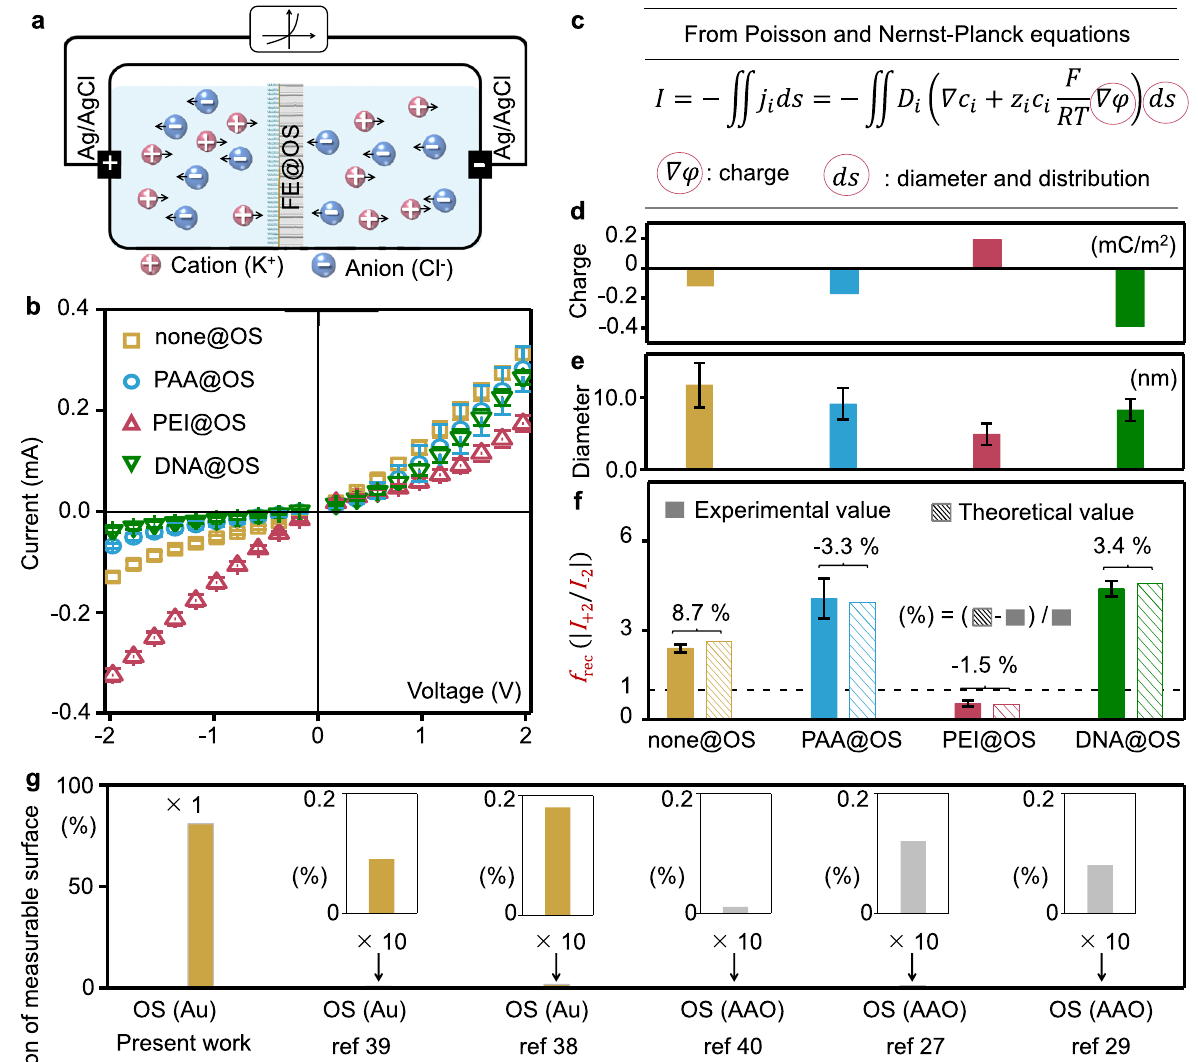
Fig. 3 Explicit role of FE OS in regulating-ion-transport. a Scheme of a two-electrode cell. b I – V curves characterizing the ion transport through nanochannel-system. c The PNP equation was used for numerical simulations of the effect from FE OS on the ion transport through nanochannel, where two variables remain: ∇ c i and ∇ φ valued by the surface charge density ( σ ) (measured by SSZPA, Fig. 3d) (1), the diameter of nanochannels (measured by AFM, Fig. 3e) (2) and the depth of FE at IW (measured by ToF-SIMS, Fig. 2g) (3) (More details in the section “ Numerical simulation ” in “ Method ” section). Thus, unless otherwise stated, the I is available from numerical simulations using the three parameters (1), (2) and (3) measurable in the nanochannel-system with FE OS only but without FE IW . f Comparison of the recti fi cation ratio ( f rec ) measured from I – V tests (experimental value) with the f rec from numerical simulations based on classical equations using measured parameters (theoretical value), but not estimated values like the previous works in 1st and 2nd stage. g Fraction of the measurable surface, which is the area proportion of the OS of measurable properties using mostly current test technologies, in the total surface occupied by FE (Details in Table S1). Data from the present work and the previous works using functional solid-state nanochannels 27,29,56 – 58 . For I – V tests, fi ve chips were used to obtain each error bar. Statistics of diameters have been done by counting 100 nanochannels for each kind of